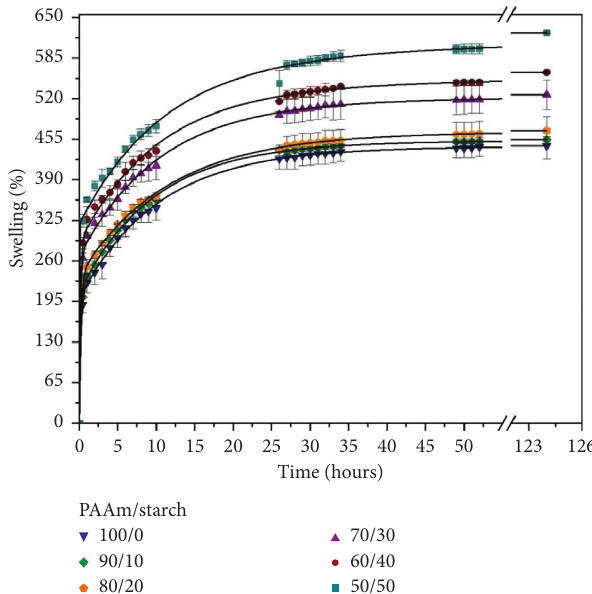
Figure 9: Swelling kinetics as function of time for hydrogels of PAAm/starch in PBS, pH 7.4 with different compositions. The error bars represent the standard deviation ( n �